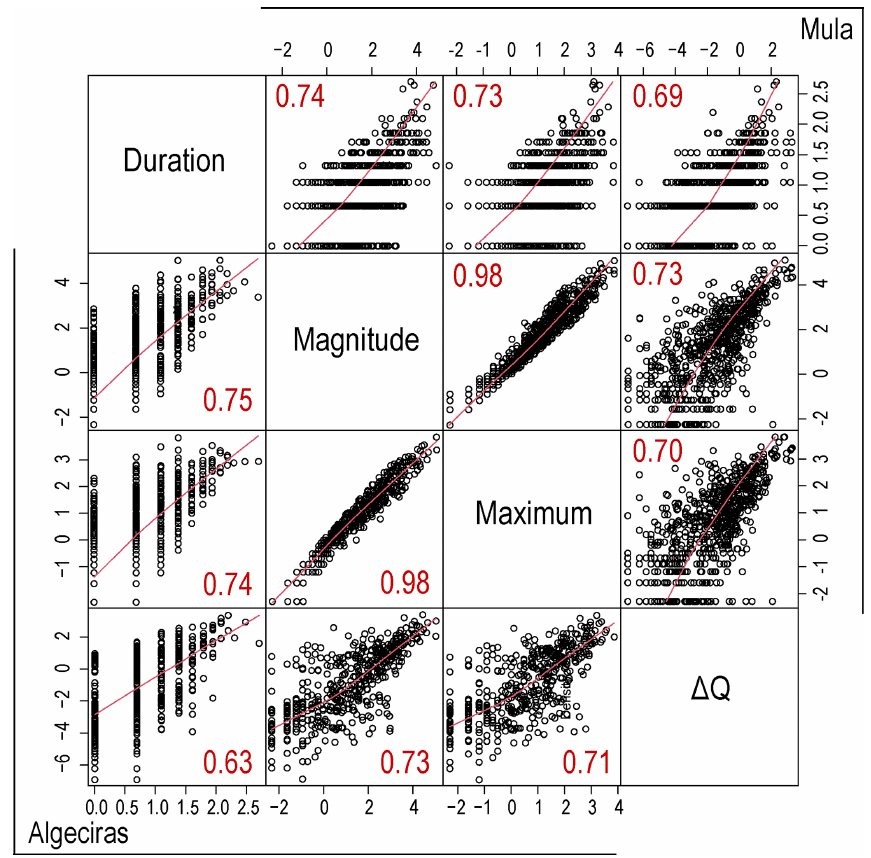
Figure 6. Values of precipitation variables and flow contribution ( (cid:49)Q ) of all events in Algeciras (bottom left side) and Mula (top right side). Magnitude and maximum variables are in logarithmic scale. Pearson correlations are shown in red (all correlations are significant at α< 0 .